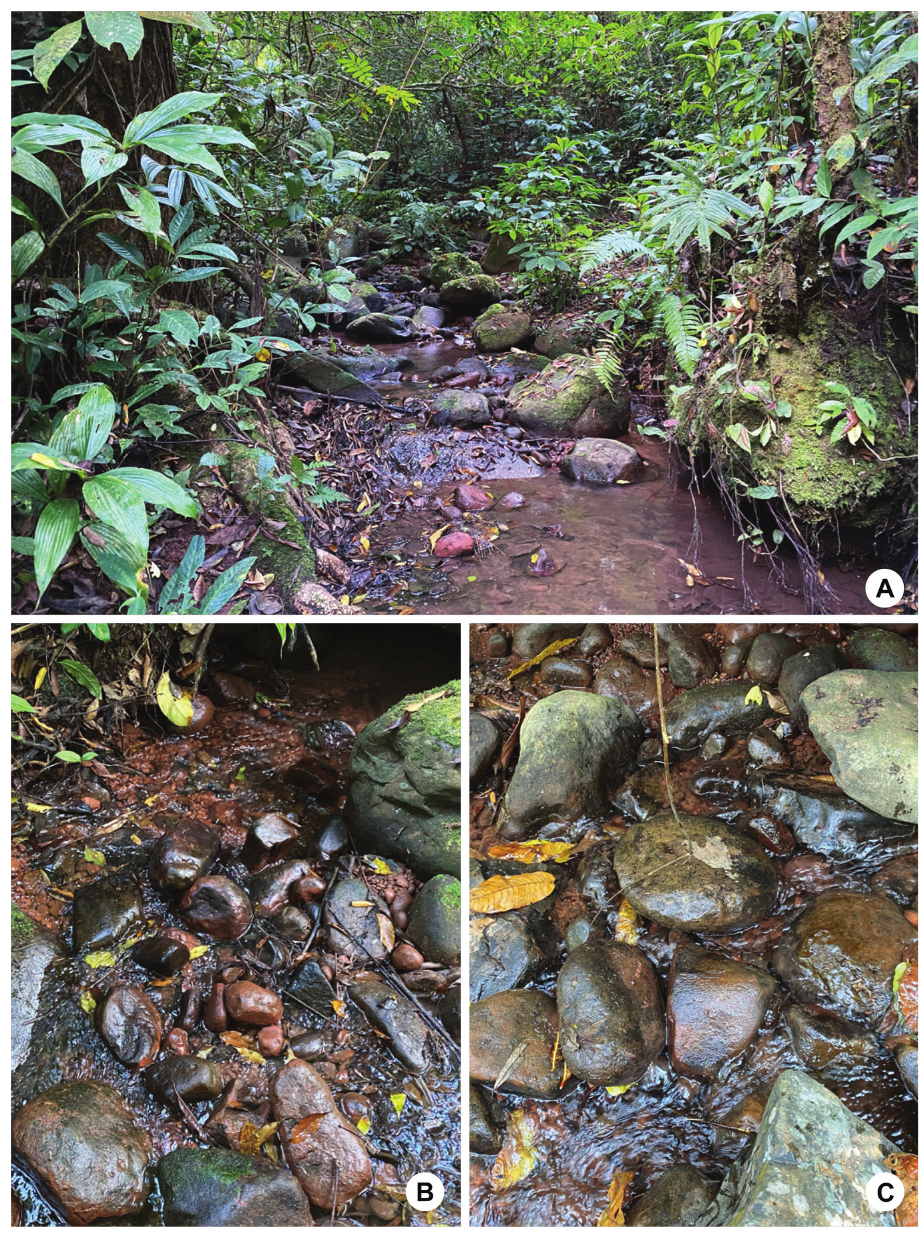
Figure 11. Habitats of larvae of Paegniodes sapanensis sp. nov. A tributary of a Sapan stream B cobble substrate with bottom sand and gravel C stream bank with